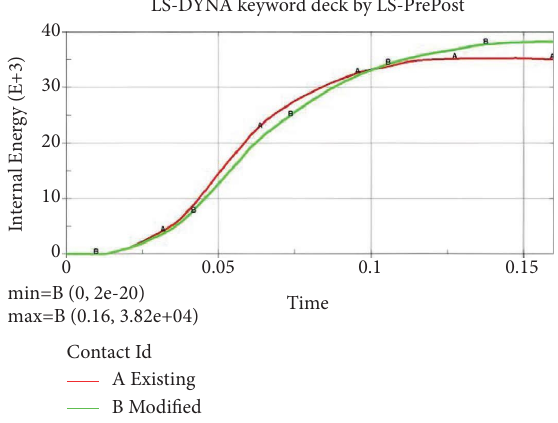
Figure 16: Energy absorbed.